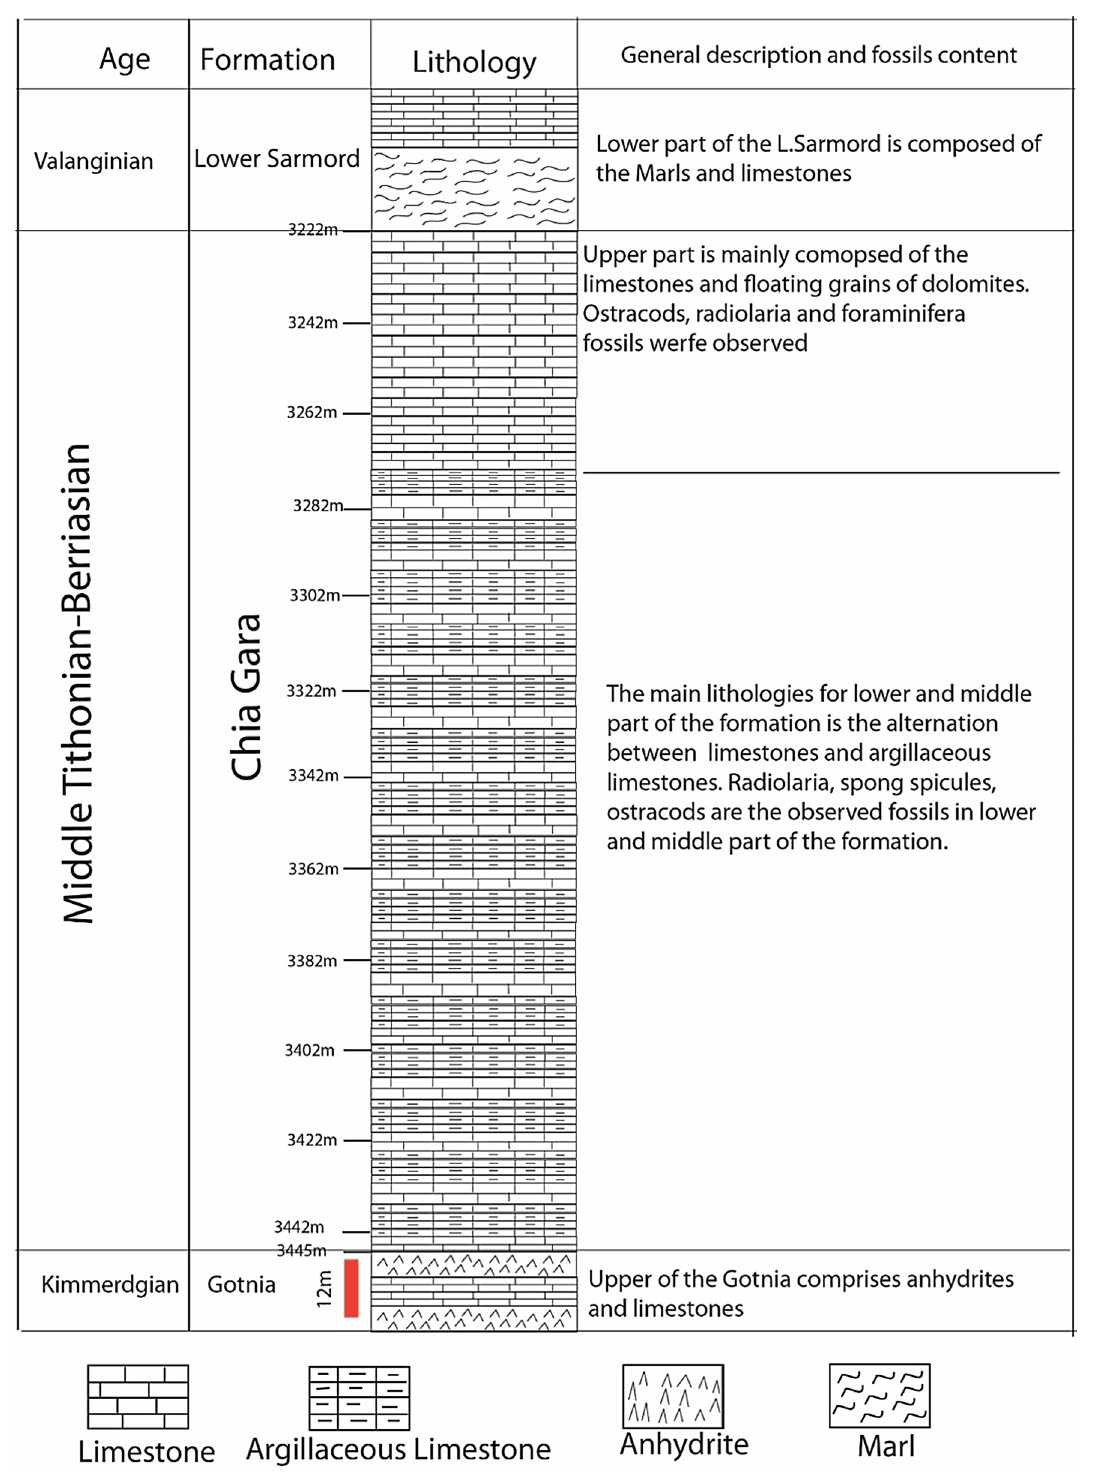
Fig. 5 Stratigraphic column of Chia Gara Formation in Well Aj-12, Salahaddin Governorate, Iraq (drawn upon description from NOC